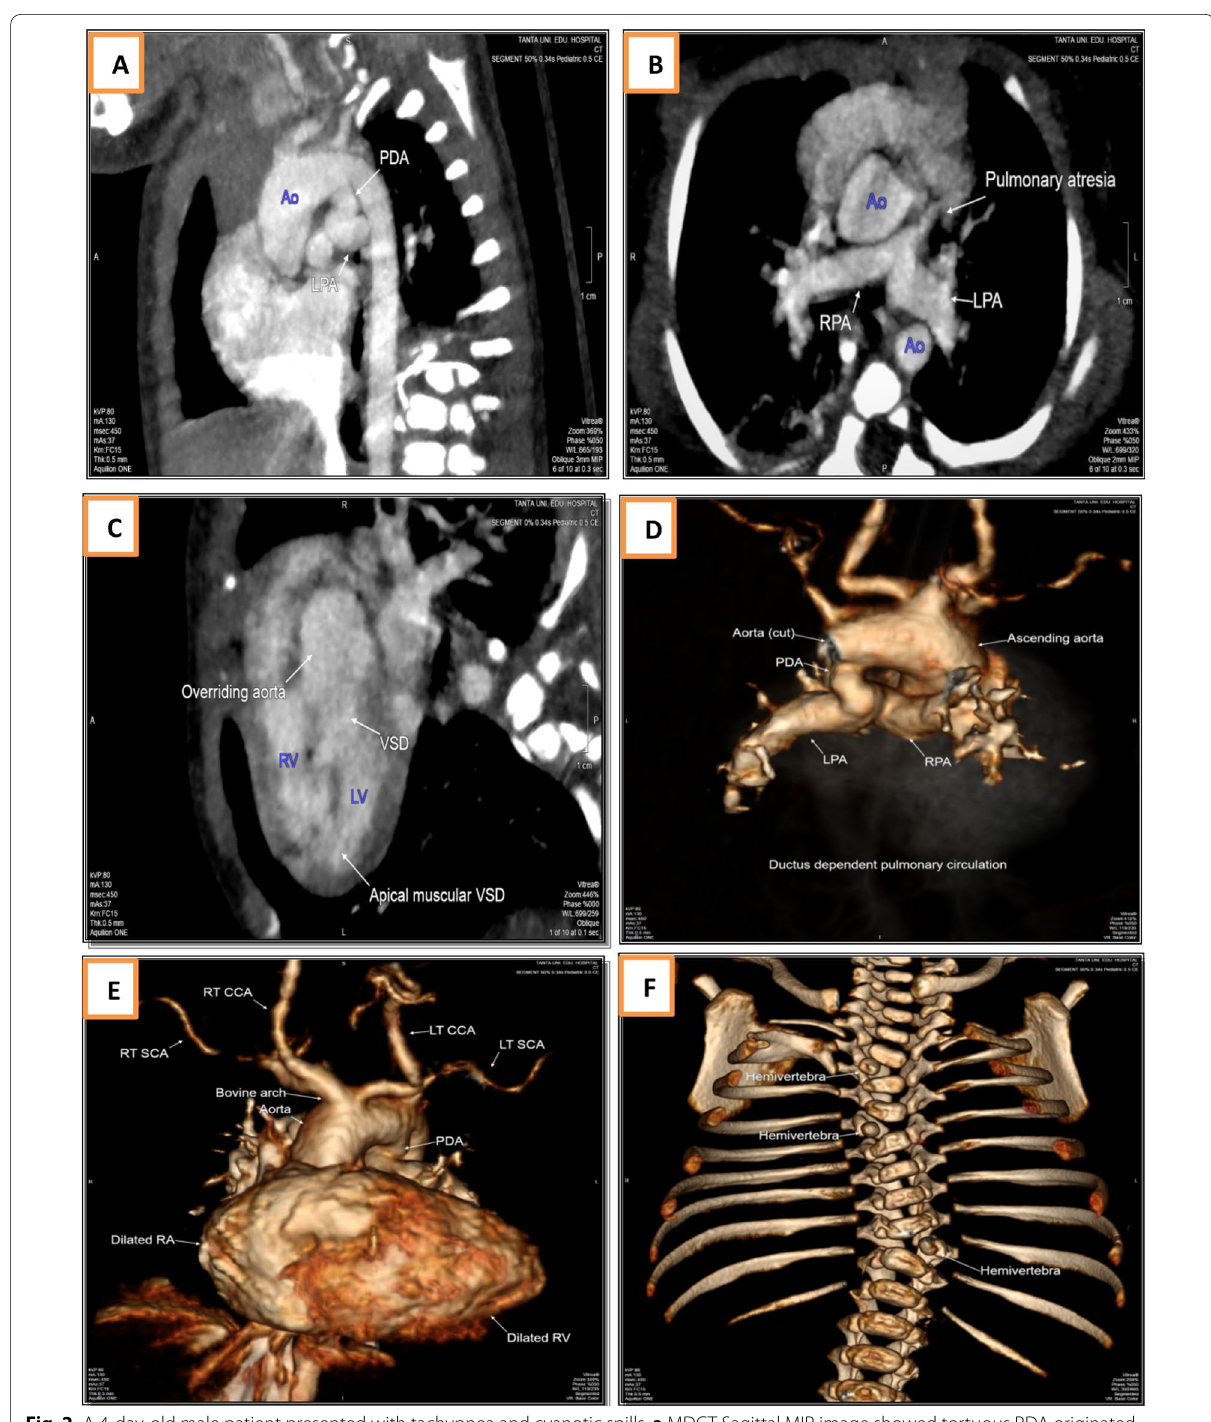
Fig. 2 A 4‑day‑old male patient presented with tachypnea and cyanotic spills. a MDCT Sagittal MIP image showed tortuous PDA originated from undersurface of distal aortic arch to LPA without stenosis (type C), b Axial MIP image showed atretic MPA with sizable RPA & LPA, c Oblique reformatted image showed overriding aorta, perimembranous outlet VSD and apical muscular VSD, d VR image showed PDA connecting between aortic arch and LPA, e VR image showed bovine branching pattern of aortic arch, PDA origin and dilated right sided cardiac chambers, f VR image showed Scoliotic deformity of dorsal spine with three dorsal hemivertebrae. A case of pulmonary atresia with duct dependent pulmonary